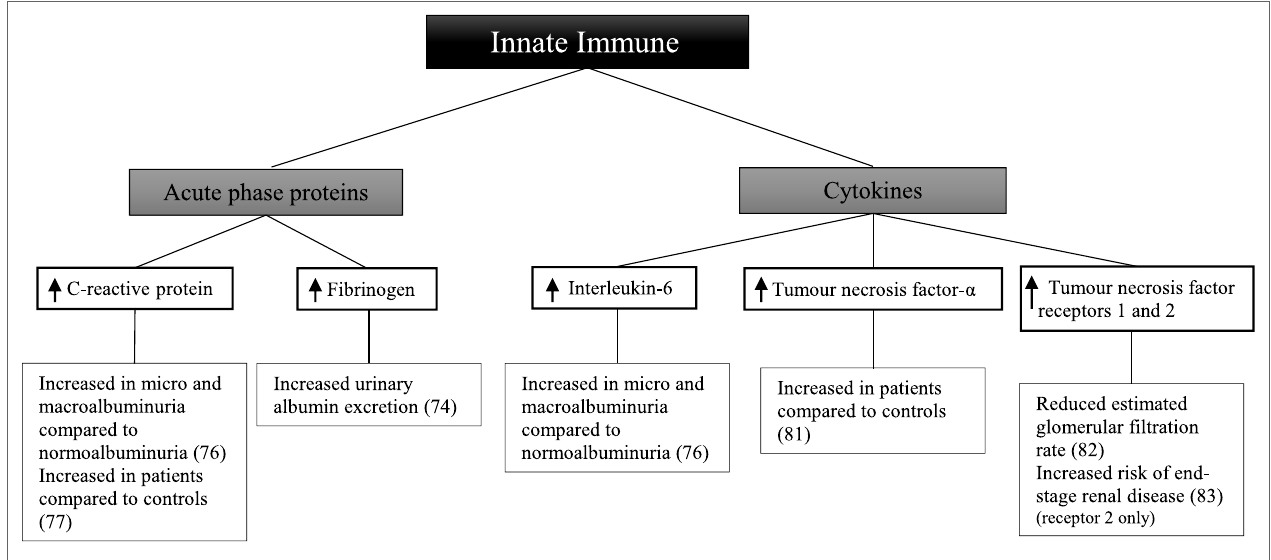
FiGURe 3 | Inflammatory components of the innate immune system and diabetic kidney disease in type 1